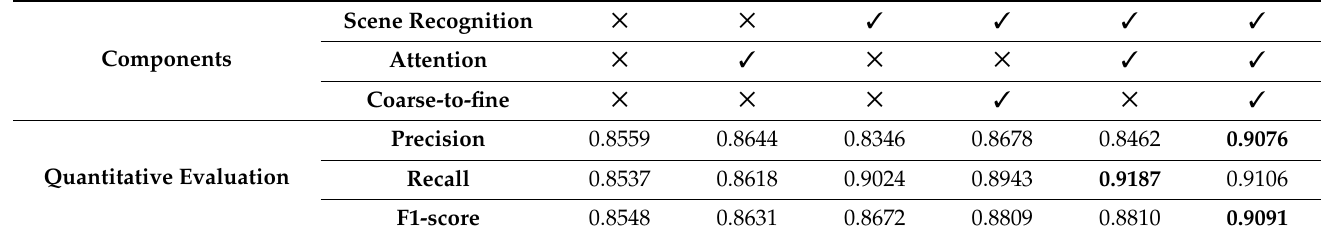
Table 2. Ablation